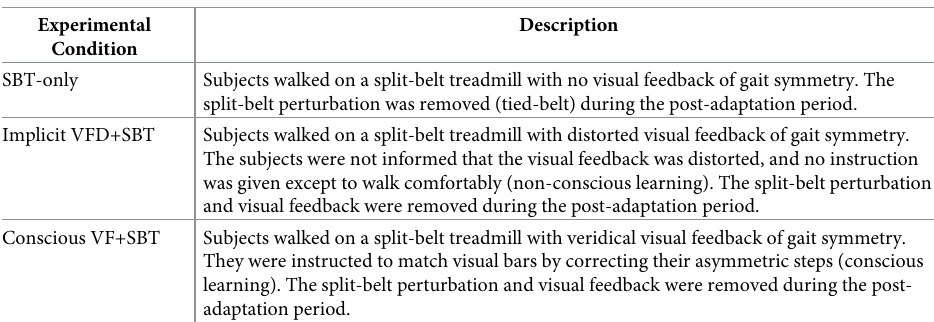
Table 1. Summary of